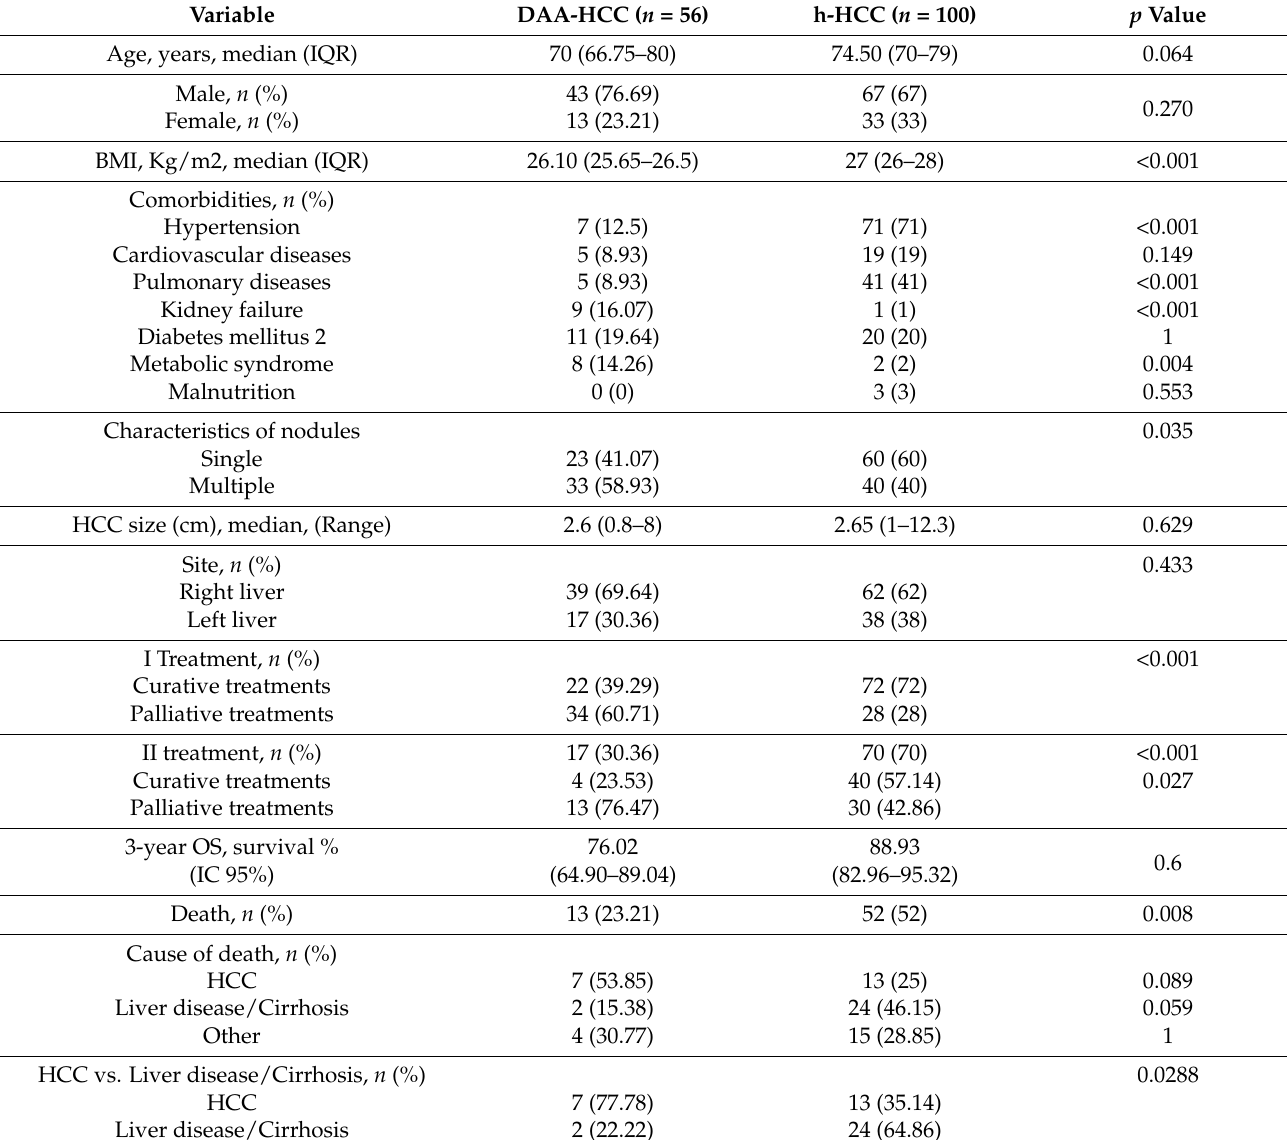
Table 3. Comparison between DAA-HCC and h-HCC